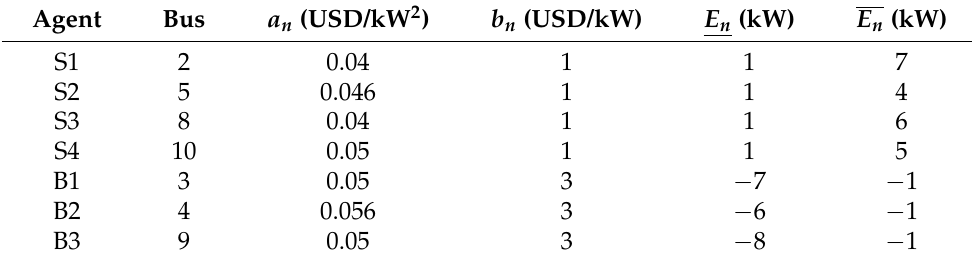
Figure 8. Test system schematic. Table 1. Sellers’ and buyers’ parameters of a simple case study.